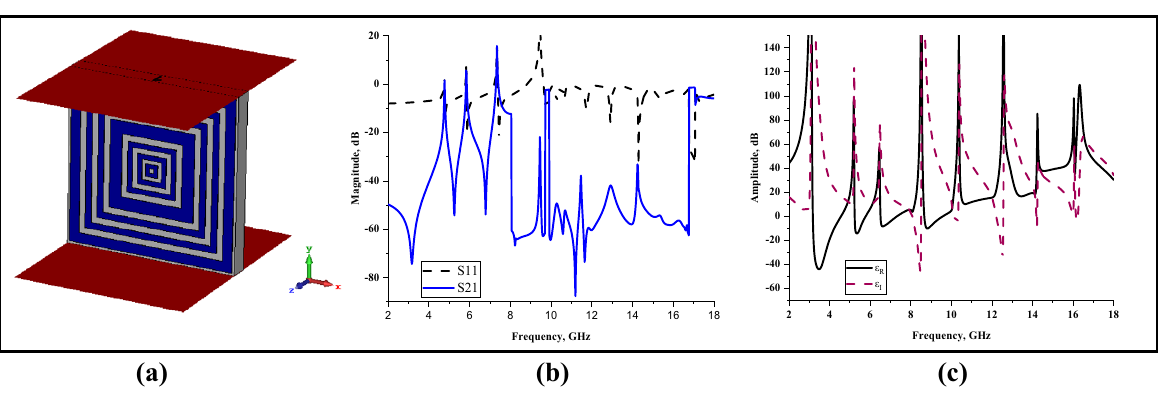
Figure 8. y-axis wave propagation: ( a ) Simulation setup, ( b ) S11 and S21, ( c )